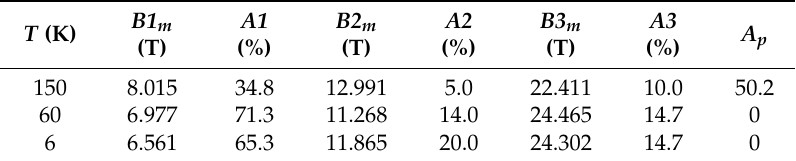
Table 3. Mean values of the hyperfine induction ( B m ) and fractional intensities ( A ) obtained for Fe 2 MnSi (RS) samples prepared by planar flow casting at low temperatures (see text). The A p corresponds to residual paramagnetic phase.